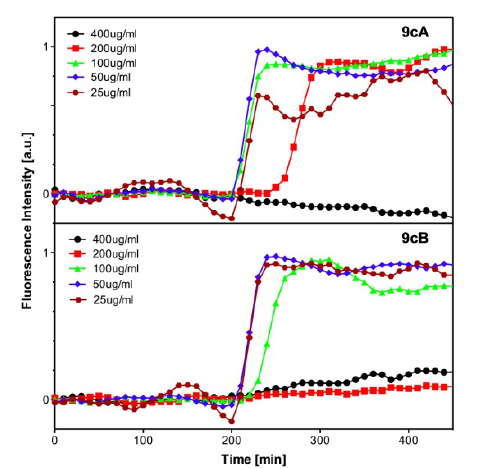
Figure 2. Fluorescence intensity time traces at 570 nm (excitation 550 nm) of cultures of E. coli containing Cy3-labeled hemocyanin as a function of antibiotic concentration. Antibiotic concentrations of 9cA and 9cB are stated.